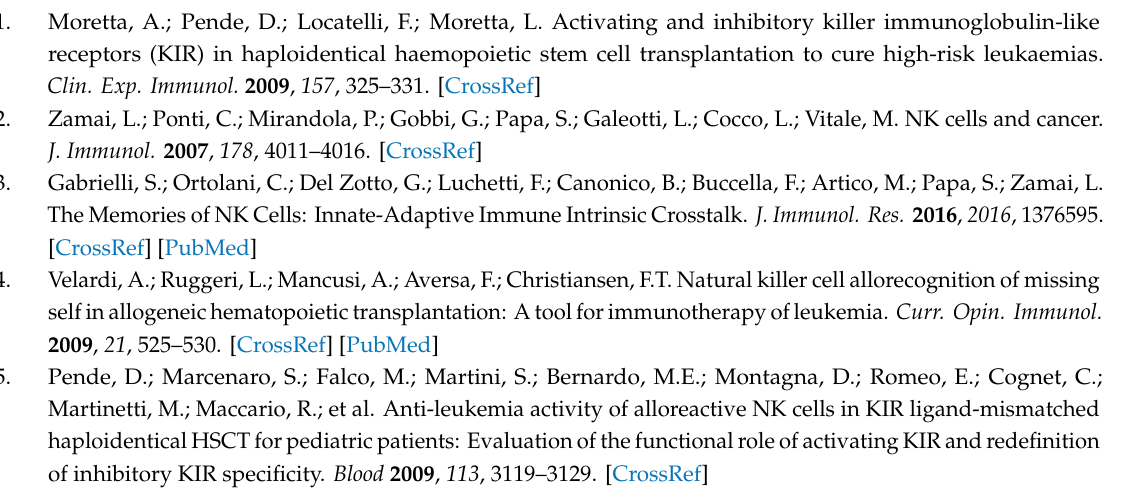
Figure S1: Testing degranulation induced by di ff erent ratios of resting lymphocytes and NKp46-coated microbeads. Figure S2: Degranulation of resting NK cells stimulated with di ff erent combinations of agonistic mAbs. Figure S3: Degranulation of resting CD56 bright and CD56 dim NK cells stimulated with di ff erent combinations of agonistic mAbs. Figure S4: Degranulation of resting licensed and unlicensed CD56 dim NK cells stimulated with di ff erent combinations of agonistic mAbs. Figure S5. Degranulation of cultured NK cells stimulated with two di ff erent anti-LFA-1 β 2-chain agonistic mAbs. Figure S6: Flow cytometry dot plot analysis of trogocytotic transfer from target to NK